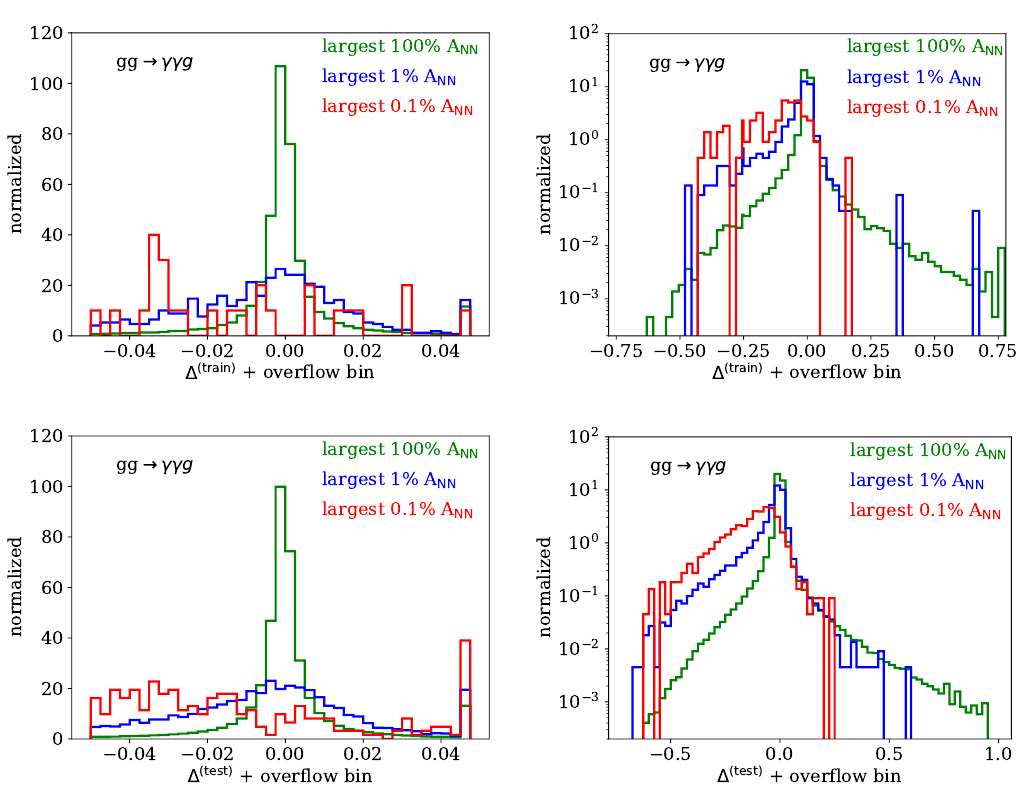
Figure 2: Performance of the BNN in terms of the precision of the generated ampli- tudes as defined in Eq.(3). In the upper panels we evaluate the training datasets, while in the lower panels we evaluate the independent test datasets. The left and right panels show the same information on linear and logarithmic scales.